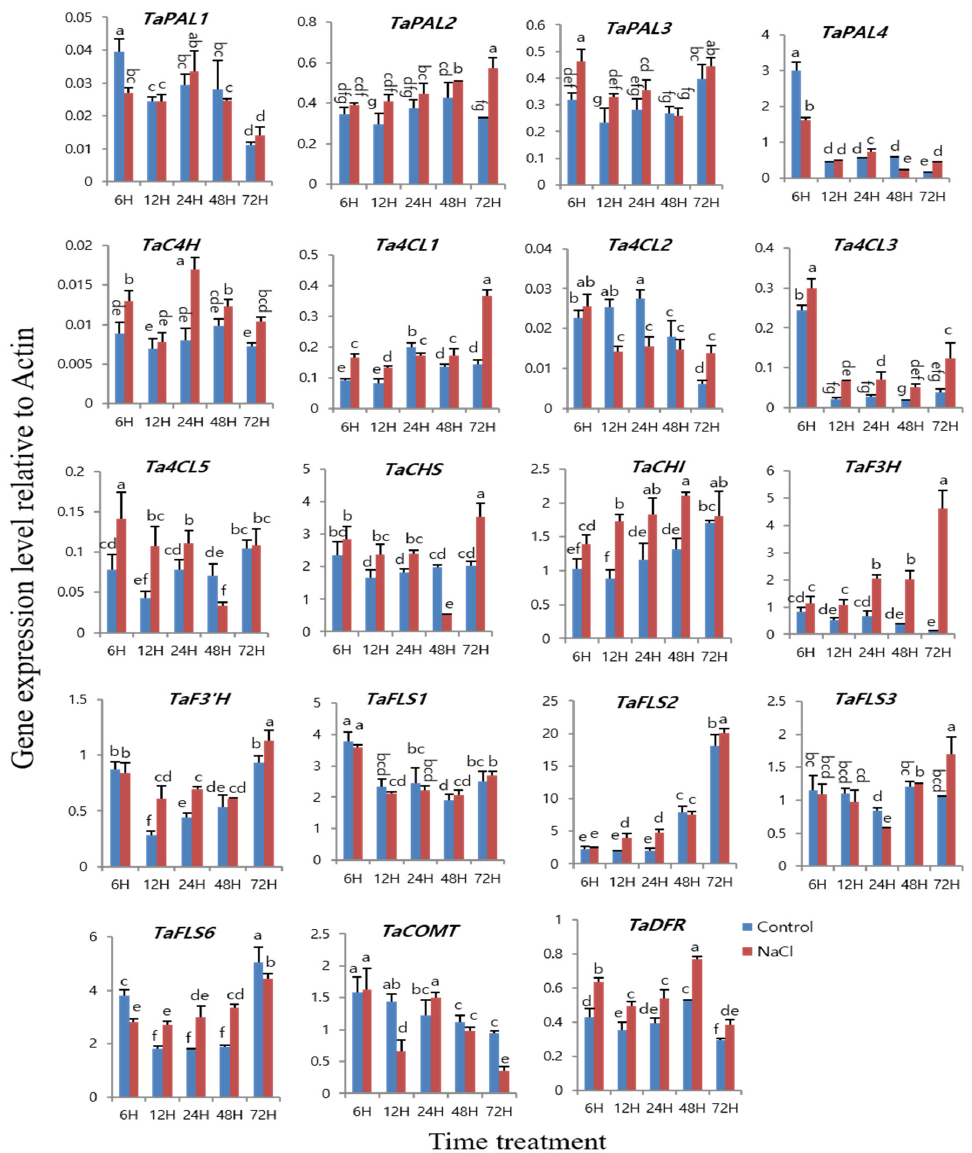
Figure 5. Expression of phenylpropanoid biosynthetic genes in 6-day-old wheat plantlets after 50 mM NaCl treatment for 6, 12, 24, 48 and 72 h. The means and SD were calculated from three biological replicates. Letters a-g denote significant differences ( P < 0.05).